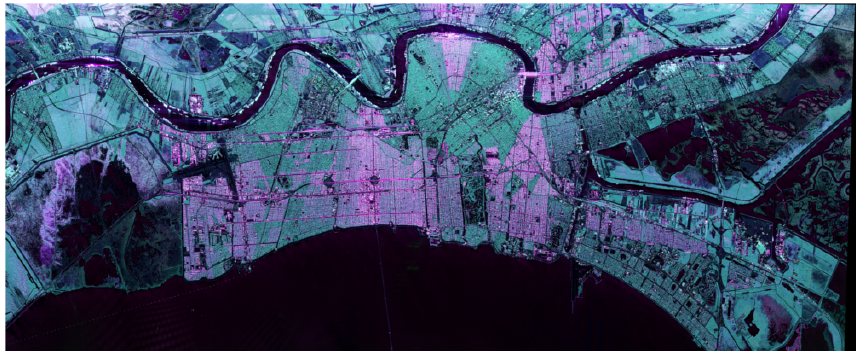
Figure 1. PolSAR image acquired by UAVSAR in the Pauli basis (double-bounce in red, single scattering in blue, cross-polarization in green) over New Orleans, Louisiana, U.S.